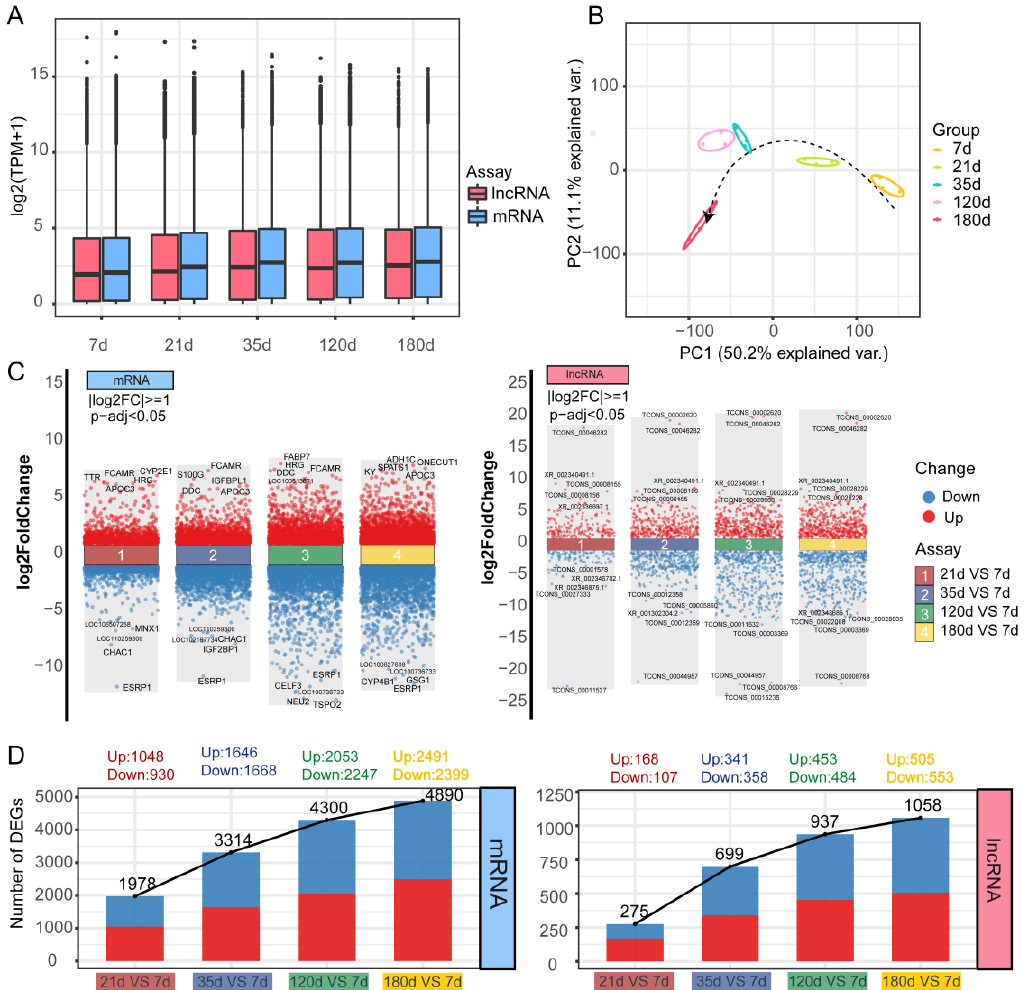
Figure 2. Analysis of differentially expressed genes. ( A ) Box plot of log2(TPM) values for mRNA (pink) and lncRNA (blue) across different time points. ( B ) PCA diagram on normalized mRNA expression values illuminating the general relationship between datasets. The arrows show the developmental trajectory during the different periods. ( C ) Differential gene expression results displaying up- and down-regulated genes in mRNA (left) and lncRNA (right) database between four comparison groups (21 d vs. 7 d, 15 d vs. 7 d, 120 d vs. 7 d, and 180 d vs. 7 d). The threshold for differential expression genes is |log2(FC)| >1 and adjust p value <0.05. Blue dots indicate down-regulated genes, and red dots indicate up-regulated genes. The top 5 up- and down-regulated gene symbols are shown in the graph. ( D ) Histogram of the number of differential expression genes for mRNA (left) and lncRNA (right) database.